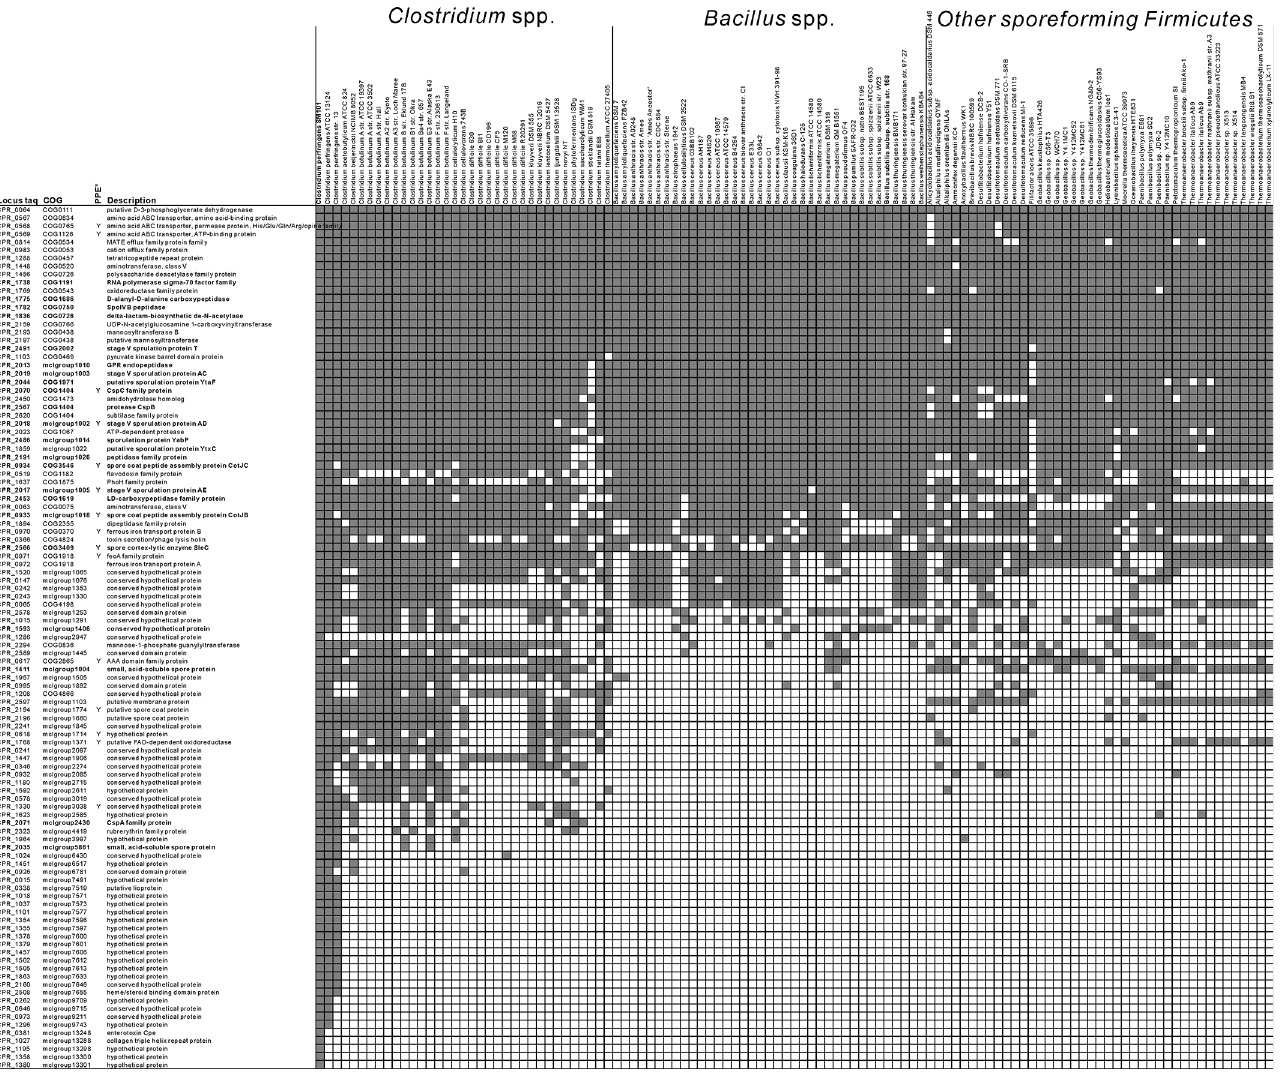
Fig 3. Cluster 1 genes and the occurrence of their homologs in other sporeforming Firmicutes. The genes in Cluster 1 are highly up-regulated during C . perfringens sporulation. The genes with known sporulation-related functions are indicated in bold against a grey background; the ones with putative functions (poorly characterized and uncharacterized) have a grey background only, while the others without specific highlights have not been associated with sporulation or are not known to determine spore properties. PPE is an abbreviation for the Potential of Polar Effect, as co-expression may occur due to high levels of expression of upstream genes in the same